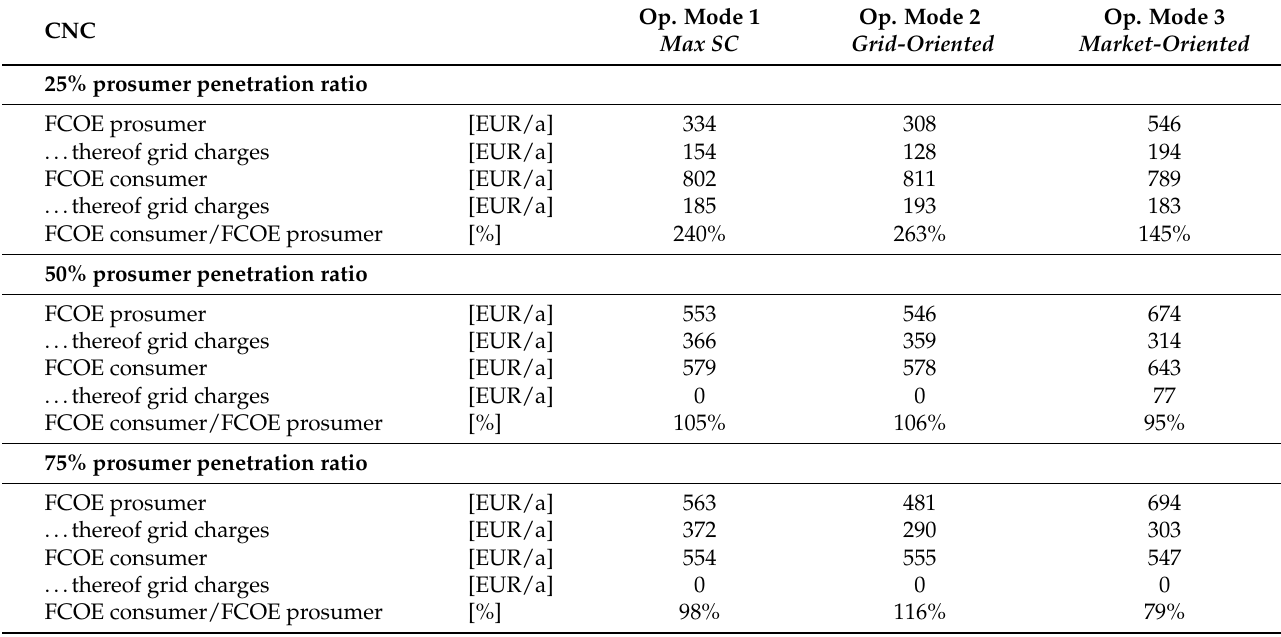
Table 7. Summary of end customer effects for peak capacity